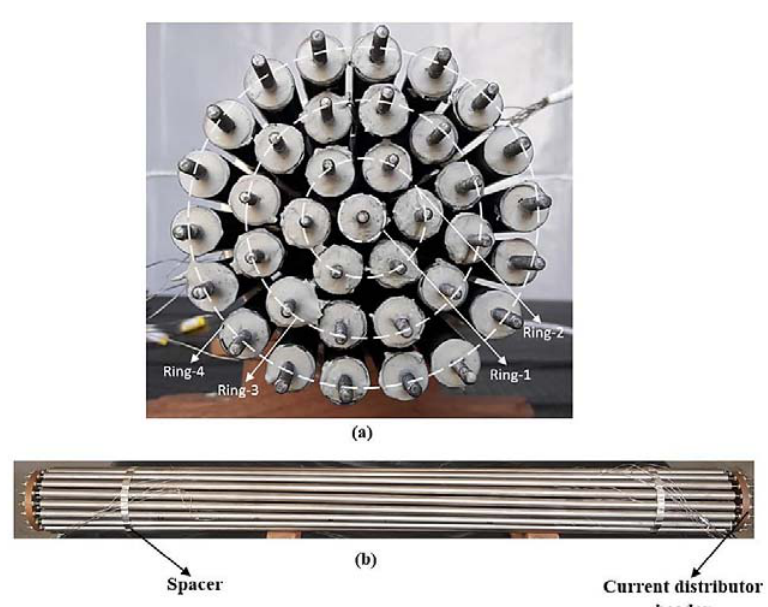
Figure 3: Fabricated fuel bundle simulator: (a) cross-sectional view (b) axial view The axial and circumferential position of the thermocouple used in the test-section is shown in the Figure 4 and 5.